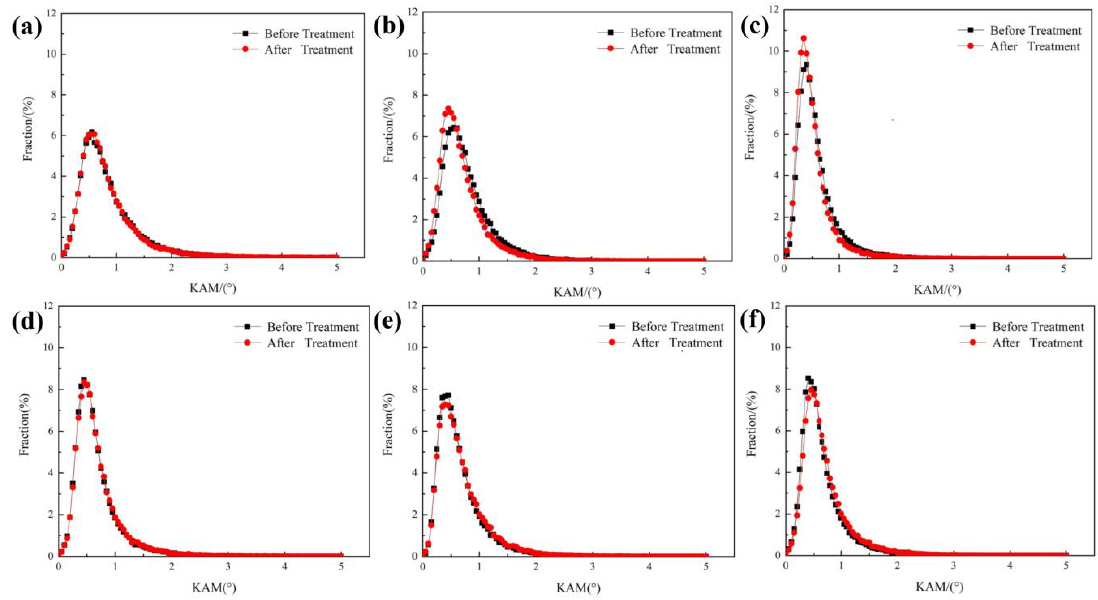
Figure 5. KAM density curves before and after treatment at di ff erent magnetic fields. ( a ) 0 T; ( b ) 1.0 T;